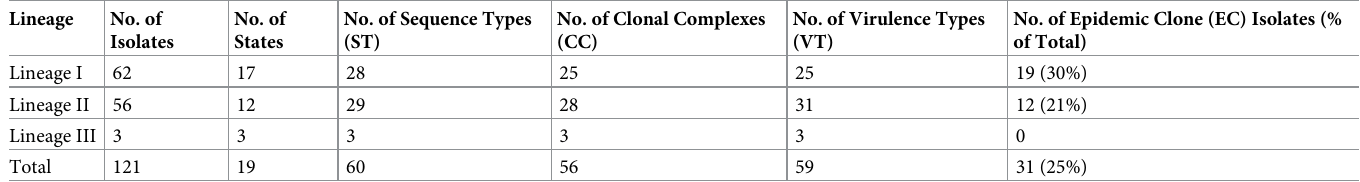
Table 1. Numbers of isolates, states from which these isolates were recovered, sequence types, clonal complexes (including singletons), virulence types, and epi- demic clones (VT epidemic clones) for each lineage represented in this study.